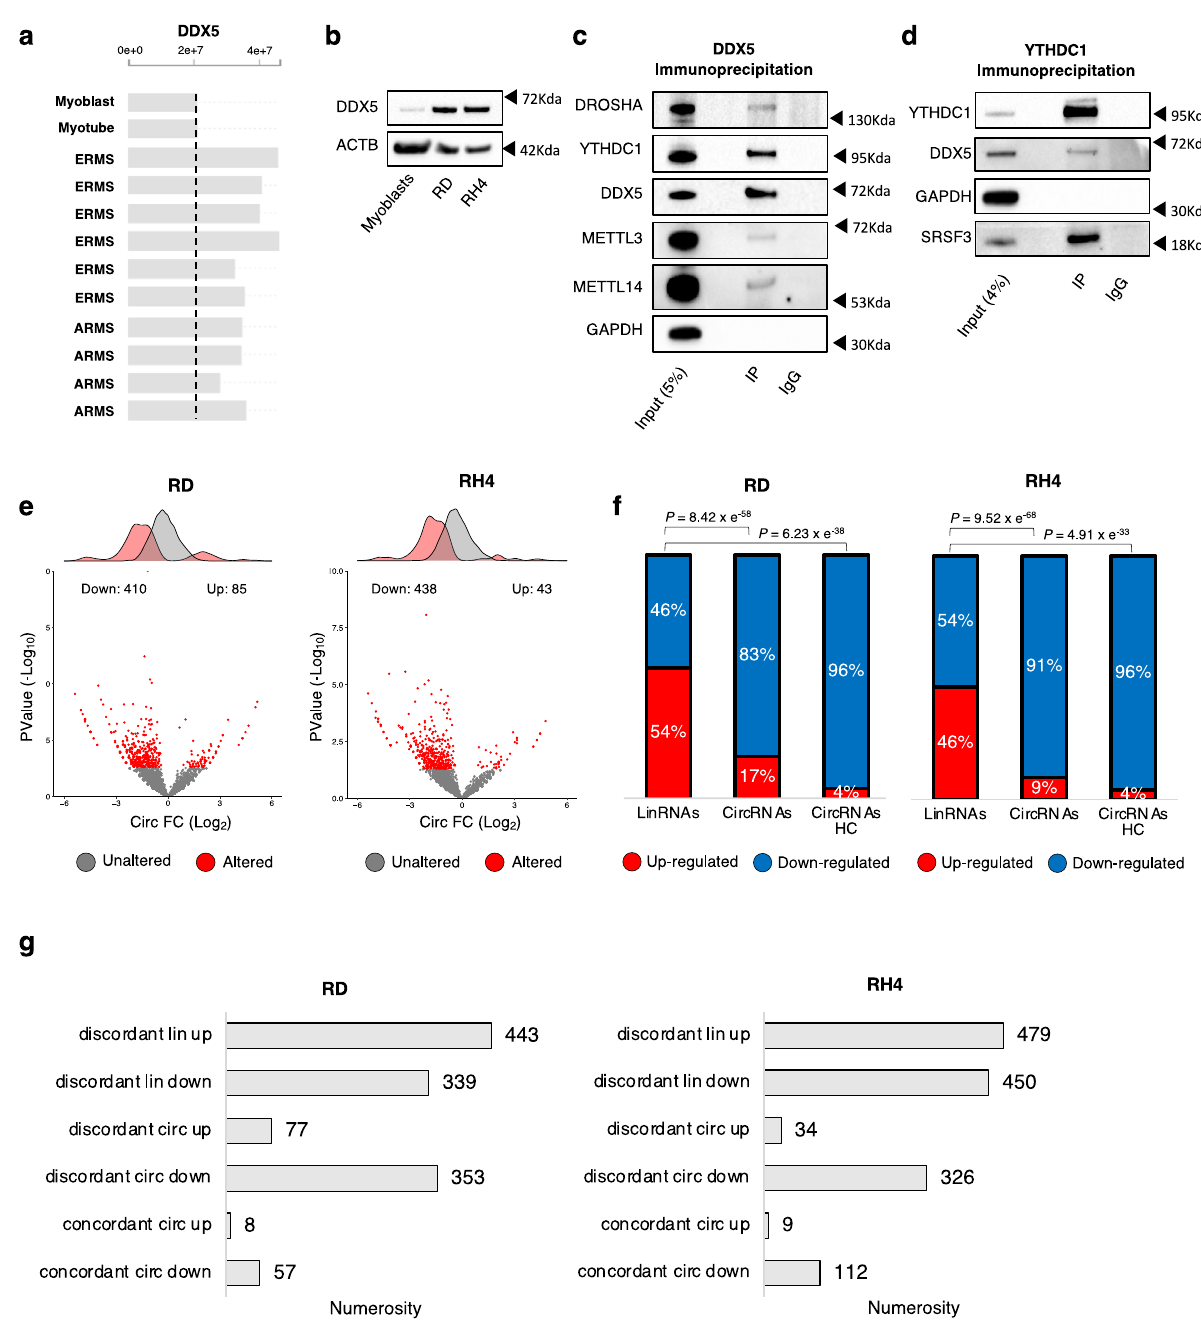
independentreplicates. e VolcanoplotsshowingforeachcircRNAidenti fi edinthe RNA-seqexperimentthelog 2 foldchangeandthe − log 10 p valueuponDDX5knock- down in RD (left panel) or in RH4 (right panel) cells. The distributions of the fold change values are shown above the volcano plots. Signi fi cantly altered circRNAs ( p value <0.05) or unaltered circRNAs are indicated by red or gray dots, respec- tively. See the methods section for statistical analyses details. f Stacked bar charts with percentage of down- and upregulated linear ( “ LinRNAs ” ), circRNAs ( “ CircRNAs ” ), or “ high-con fi dence ” circRNAs ( “ CircRNAs HC ” ) upon DDX5 knock- down in RD (left panel) or RH4 (right panel) cell lines. P -values for the differences betweenproportionswerecalculatedusingFisherexacttwo-tailedtest. g Bar-plots depictingthenumerosityofdifferentscenariosofderegulationinRD(leftpanel)or in RH4 (right panel) cells upon DDX5 knock-down. Source data are provided as a Source Data fi